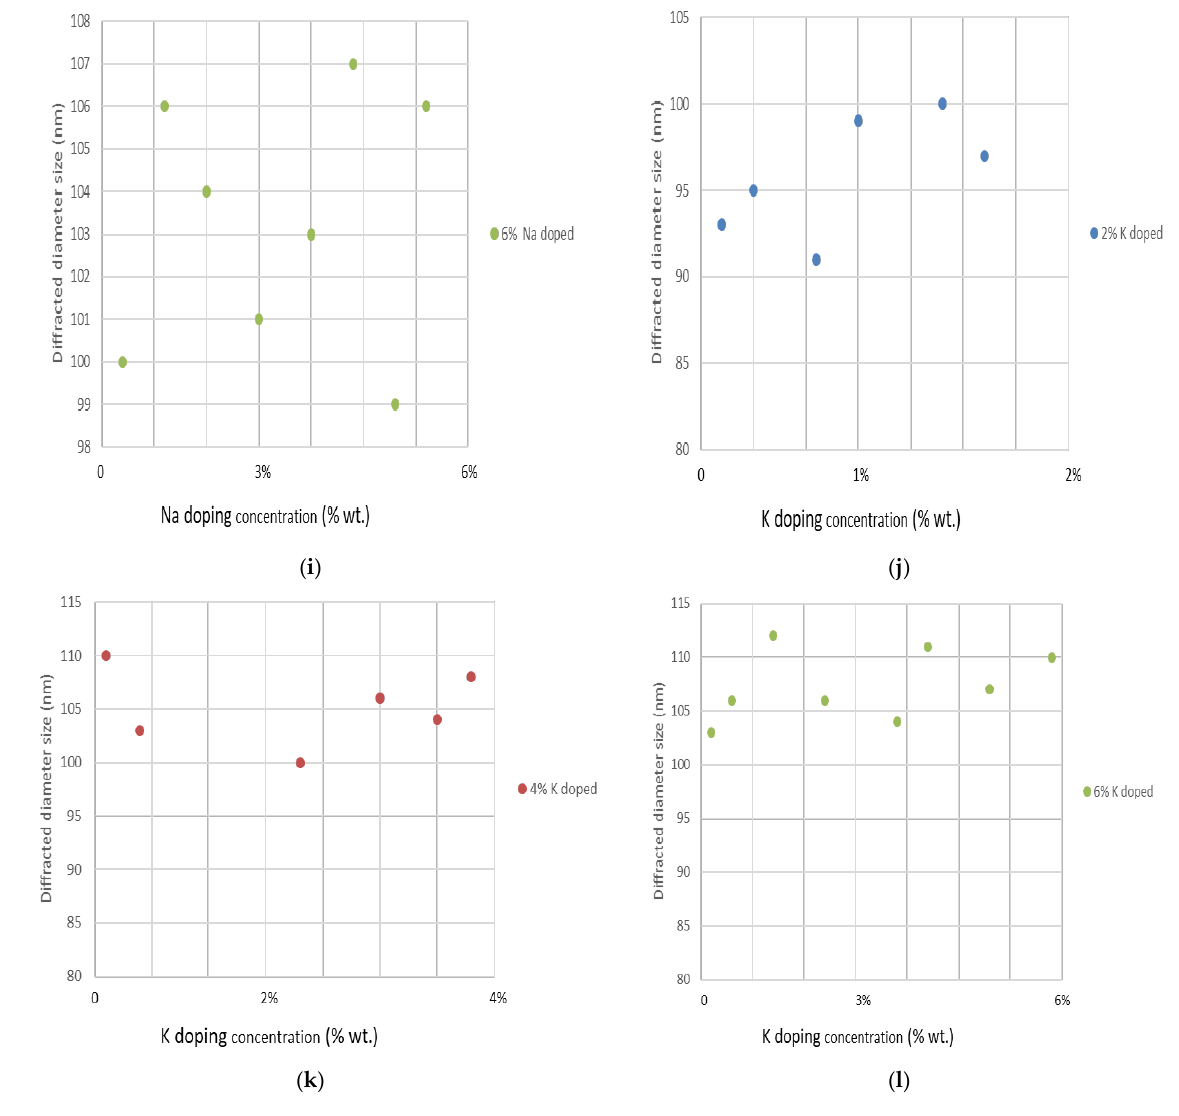
Figure 4. XRD pattern of vertically grown ZnO nanowires, ( a ) Na-doped ZnO nanowires, ( b ) K- doped ZnO nanowires ( c ) Li-doped ZnO nanowires, and ( d – l ) concentration mapping of doped Li, Na, and K, respectively.